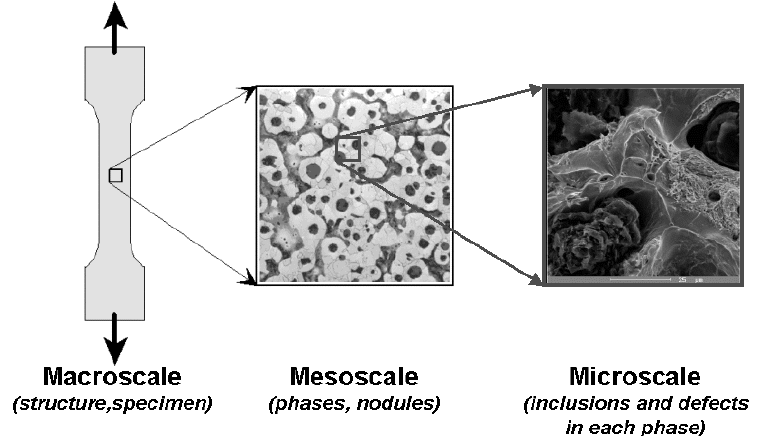
Figura 1: Scale di osservazione associate alla struttura di una ghisa